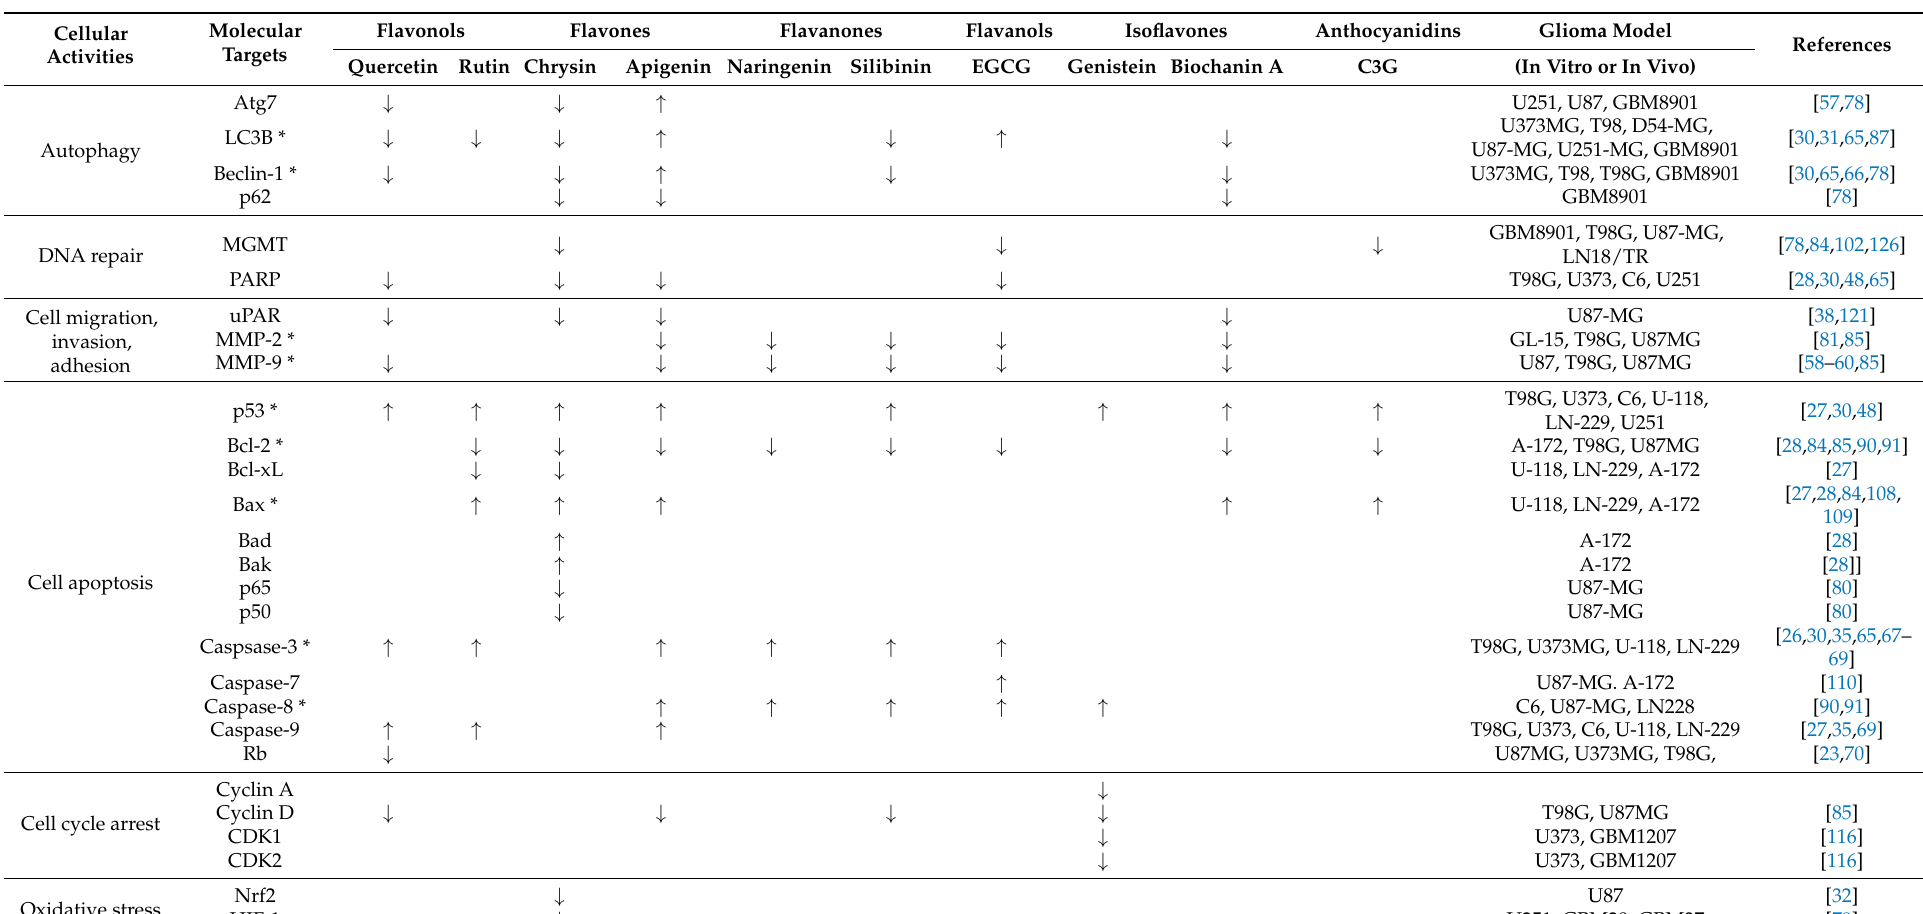
Table 2. The molecular targets modulated by flavonoid subclasses: flavones, flavonols, flavanols, flavanones, isoflavones, and anthocyanidins and their compounds: quercetin, rutin, chrysin, apigenin, naringenin, stilbene, ECGC, genistein, biochanin A and C3G in high-grade adult-type diffuse glioma. * represents common targets of flavonoid compounds. ↑ represents upregulation; ↓ represents downregulation of molecular